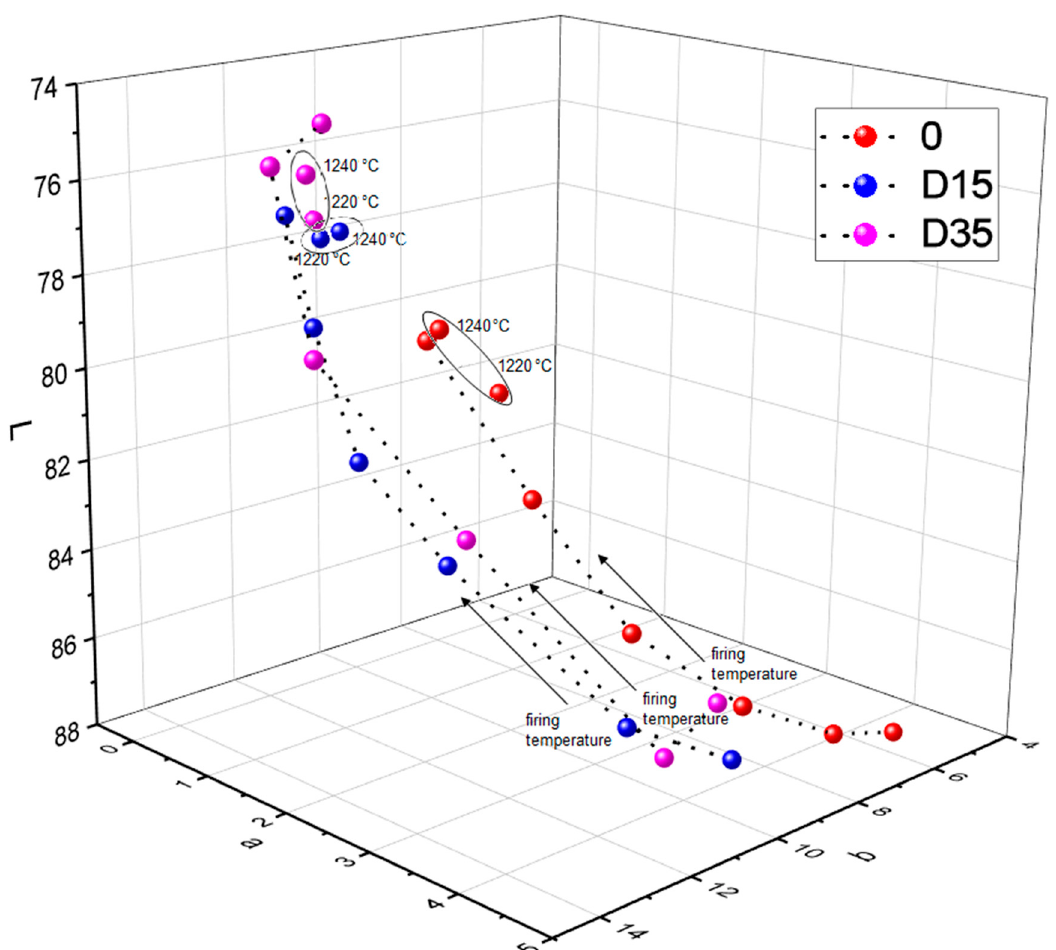
Figure 8. Dependence between L, a, b color indicators and firing temperature of ceramic materials .